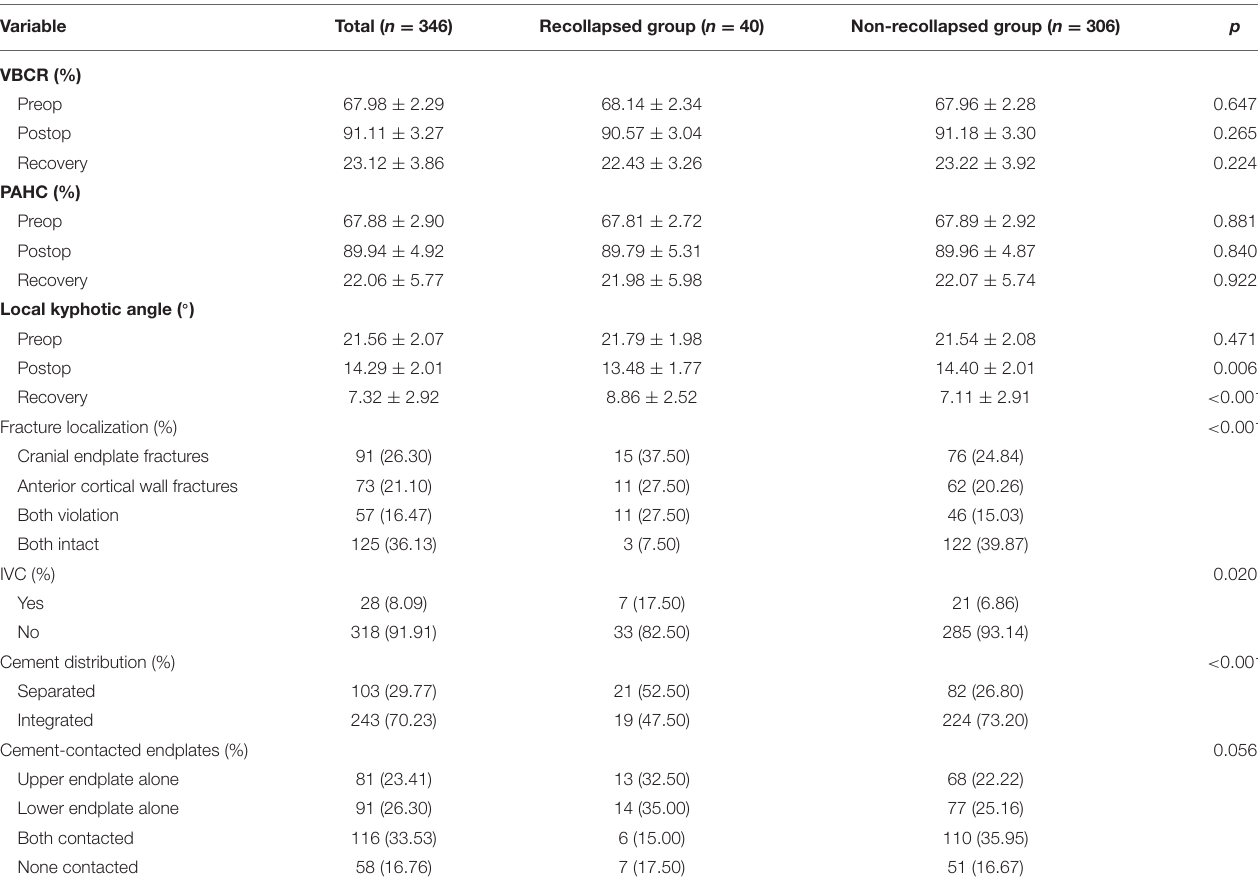
TABLE 2 | Comparison of the radiologic indeces between patients with and without recollapse.